Question: What visual encoding does this figure use to show its data?
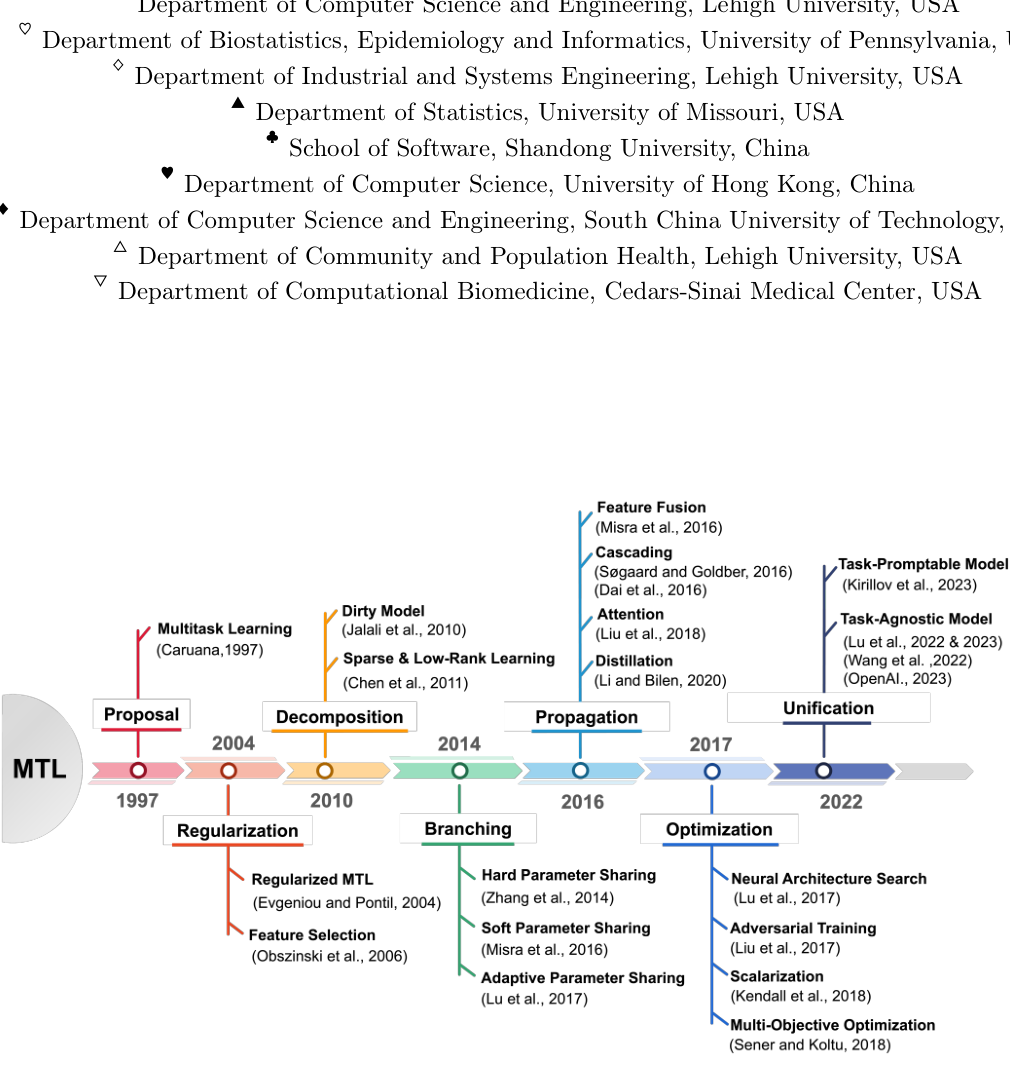
Answer: line